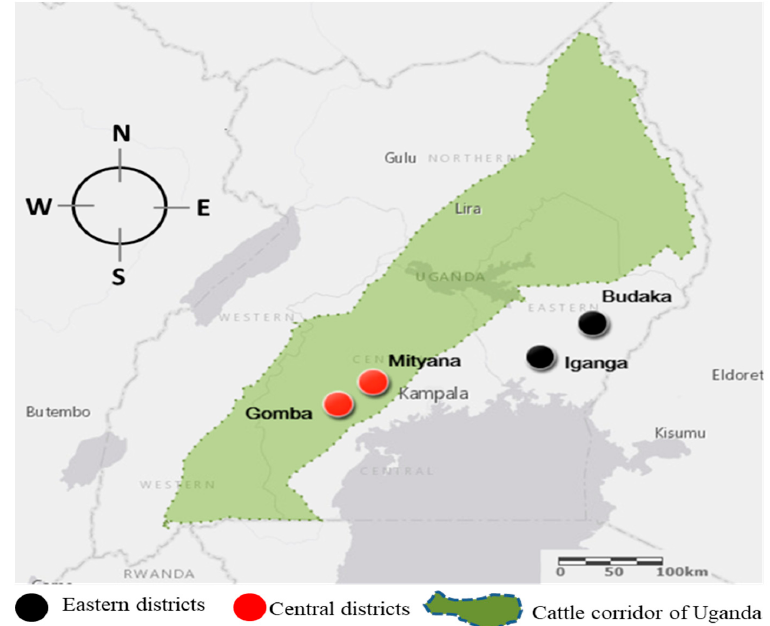
Figure 1. Geographical distribution of the sampling areas. A total of 401 blood samples were obtained from cattle from four locations across Uganda: Gomba ( n = 105), Buddaka ( n = 101), Iganga ( n = 100), and Mityana ( n = 95).